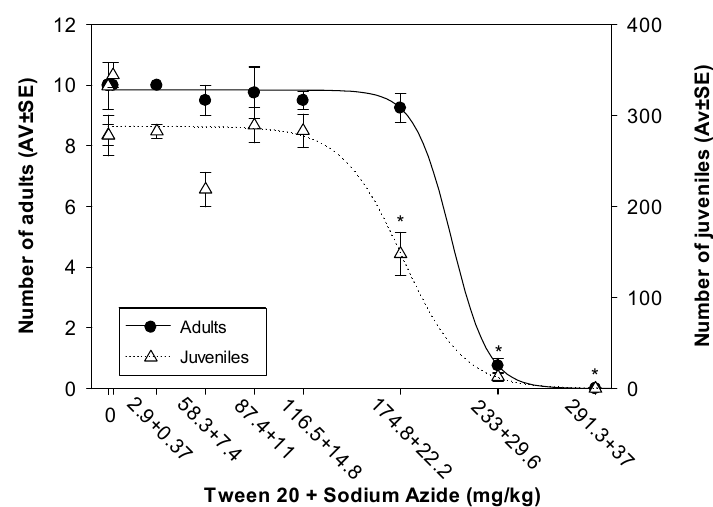
Figure 3. Enchytraeid reproduction test data in terms of survival (number of adults) and reproduction (number of juveniles) of Enchytraeus crypticus after 21 days exposed to the dispersant solution—tween 20 and sodium azide—in LUFA 2.2 soil. Data are expressed as average value (AV) ± standard error (SE). Lines represent the models fit to data. * Significant differences to control ( p < 0.05).